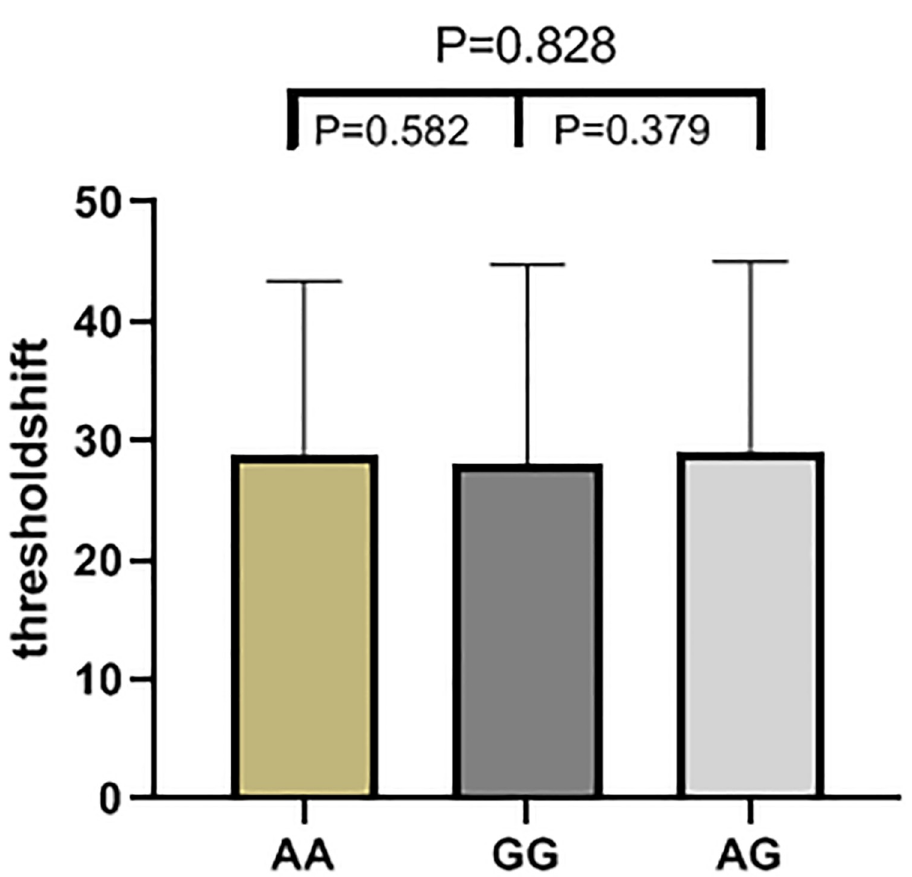
Fig 3. The genotypic distributions of rs652921. The height of each column is the value of hearing threshold and each column stands for 1 genotype.